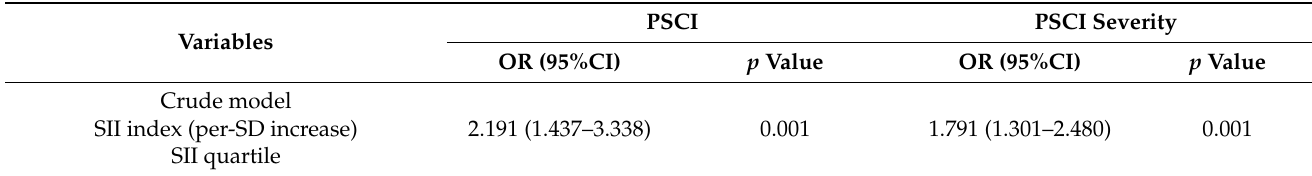
Table 3. Multivariate analysis for the association of the SII index with